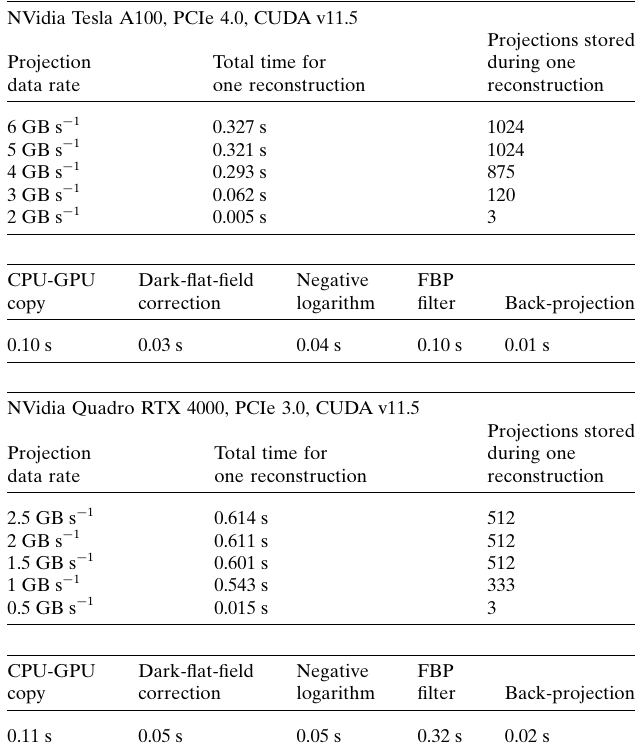
Table 1 Performance measurements for two different GPUs used for reconstruc- tion of three ortho-slices from 16-bit projections each having sizes (1024 (cid:7) 1224), and acquired at different rates. Streaming projections acquired during one reconstruction are stored in a buffer of size 1024 for Tesla A100 and 512 for Quadro RTX 4000, representing an angular interval of 180 (cid:4) ; if reconstruction is not fast enough then projections in the buffer are replaced by new ones. Lower table rows show GPU computational times for each reconstruction